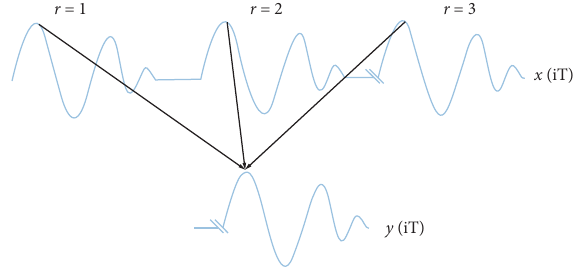
Figure 2: Layout for obtaining a time-synchronous average (source: